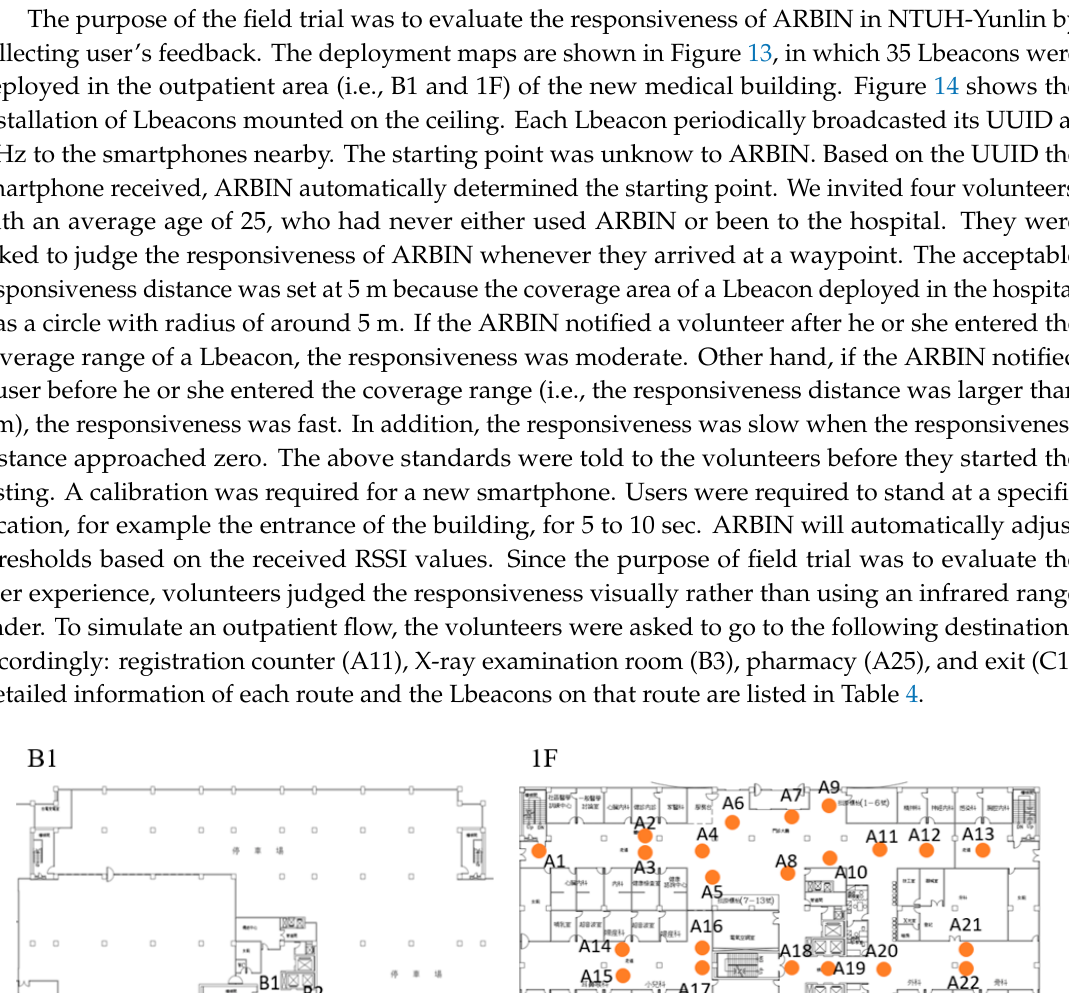
Figure 14. The installation of Lbeacons in the outpatient area of NTUH-Yunlin. As Table 4 shows, each volunteer passed through nine Lbeacons on their way to the destinations. They judge the responsiveness whenever they reach a waypoint. The results show that 97% (35/36) of the user feedbacks were “moderate”, which indicates that ARBIN can properly notify users when they approach a waypoint. Volunteer C marked A18 as slow because he experienced a deferred notification when he approached A18. A possible solution could be slightly decreasing the threshold of A18 to make ARBIN react properly. In our implementation, there was no 3D AR model placed at the destination. Therefore, we asked volunteers to check if ARBIN could guide them to the destinations successfully. The results show that ARBIN could successfully guide the volunteers to their destinations.